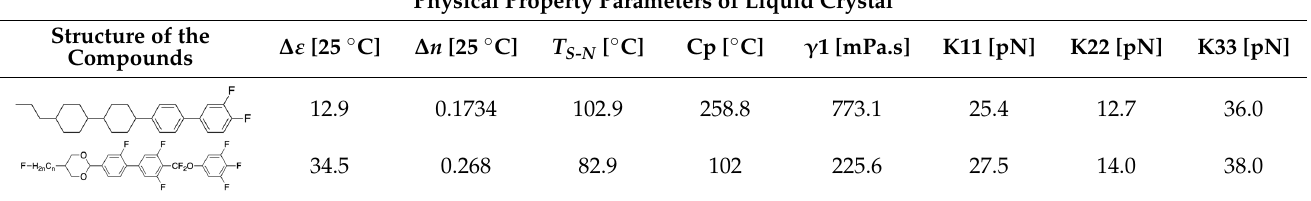
Table 3. The contrast in performance.